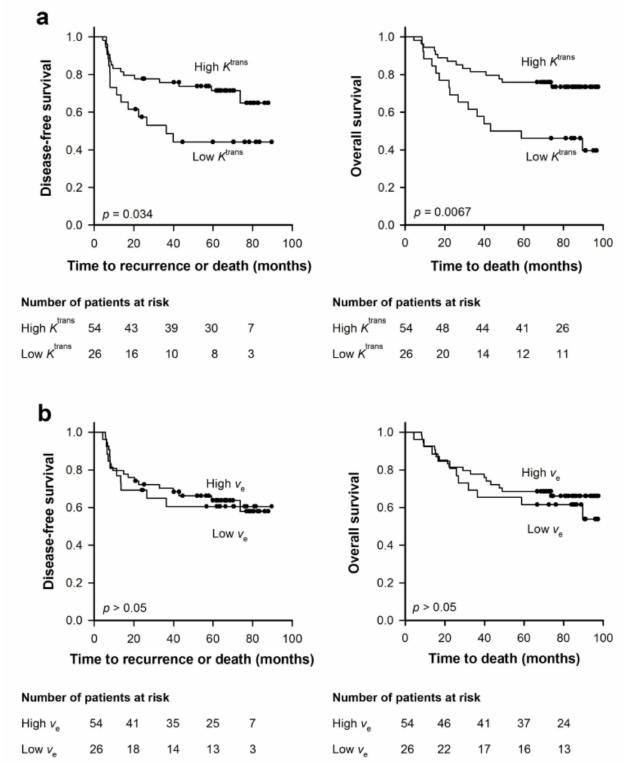
Figure 9. Eighty patients with locally-advanced cervical carcinoma were subjected to DCE-MRI prior to cisplatin-based chemoradiotherapy. The patients were divided in two groups consisting of one-third and two-thirds of the patients. The figure shows Kaplan–Meier curves for disease-free and overall survival of the 26 patients with lowest and the 54 patients with highest median K trans ( a ), and the 26 patients with lowest and the 54 patients with highest median v e ( b ). p -values were obtained by log-rank test. Modified from Lund et al.